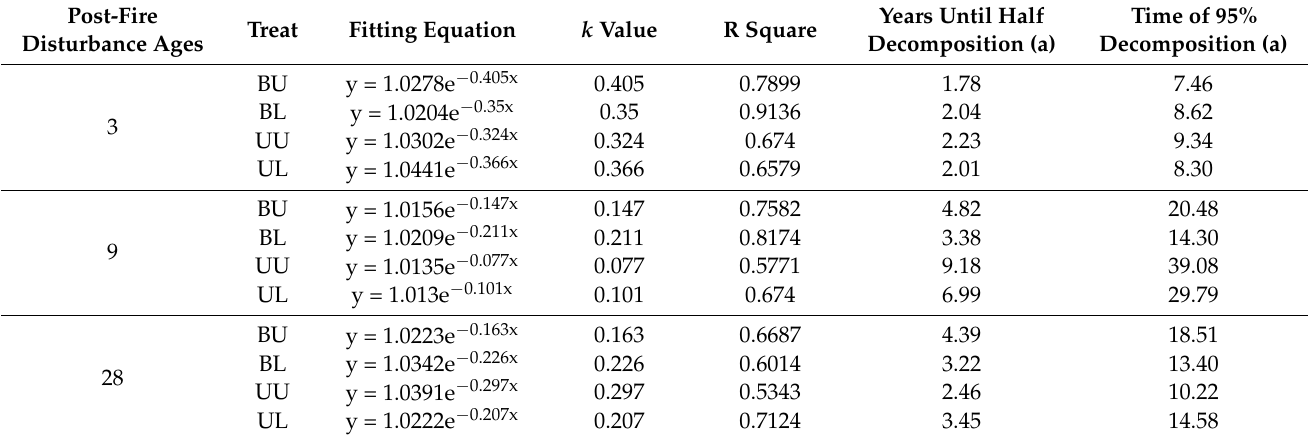
Table 2. Fitting rate of coniferous litter decomposition ( n =